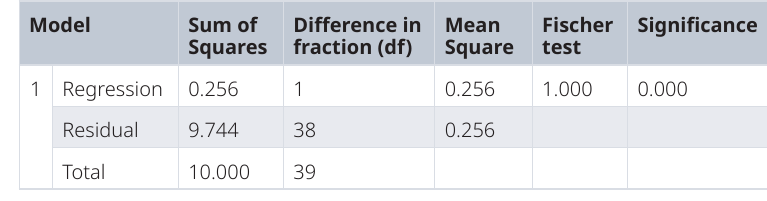
Table 4b. Analysis of variance.